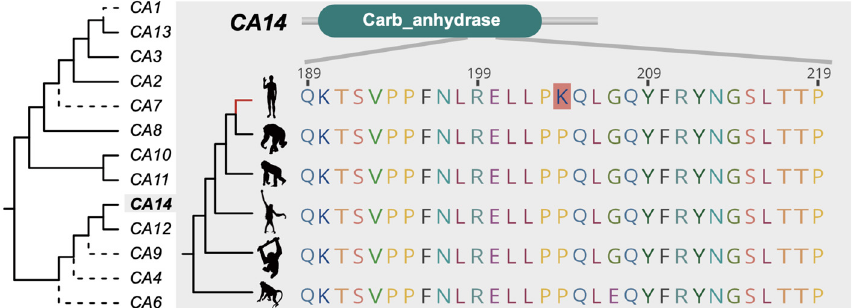
Figure 3. CA14 , one of the copies from the carbonic anhydrase multigene family, is positively selected in the human lineage. Lys 204 was found to be under positive selection in CA14 across all six primates. The gene phylogeny of the CA gene family in humans is shown on the left. The solid lines indicate genes present in all six primates and the dash lines indicate genes absent in some lineages. Animal illustrations are from phylopic.org, and are credited to NASA ( H. sapiens , https://crea-